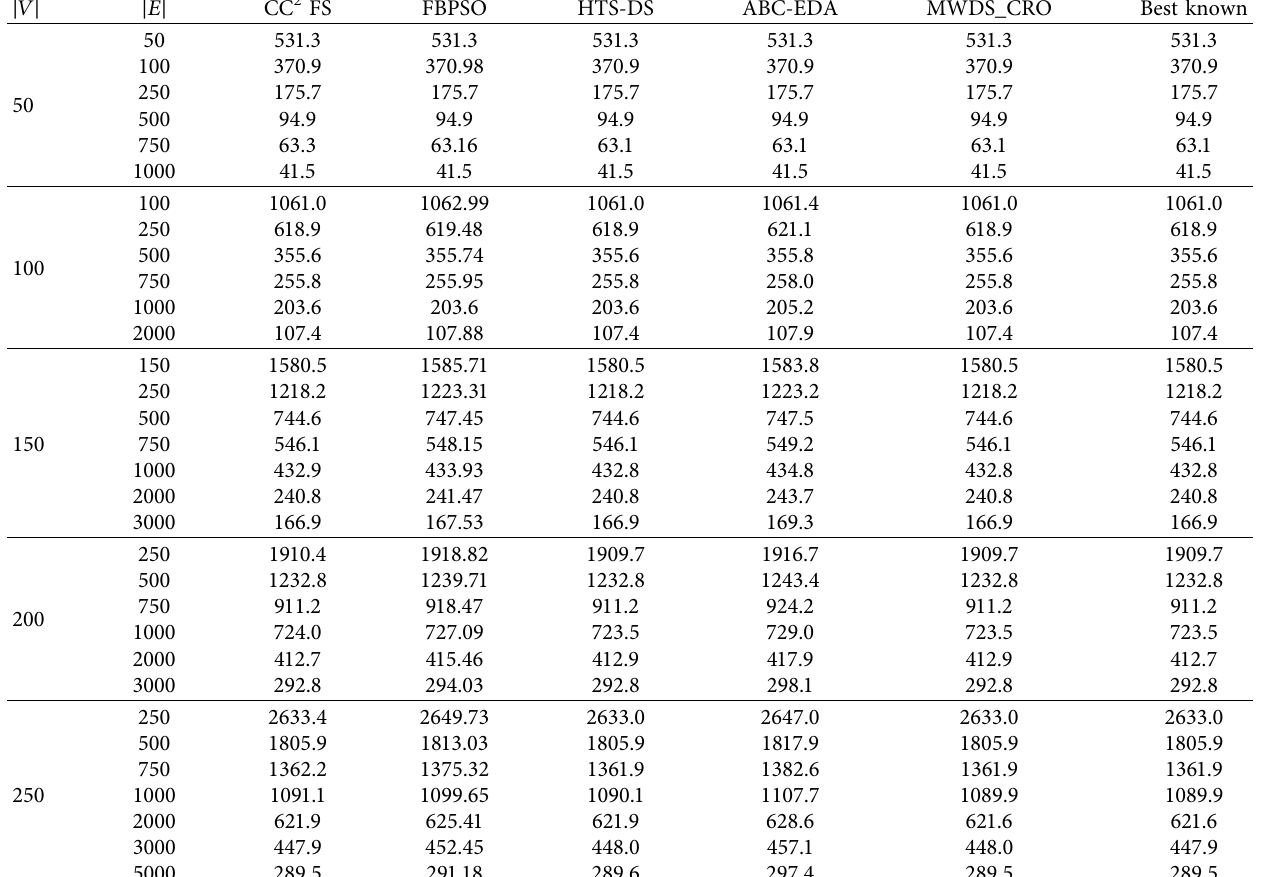
Figure 14: Beta ( β ) tuning. Table 3: Type TI class SMPI-comparison of MWDS_CRO for various parameters with recent state-of-the-art